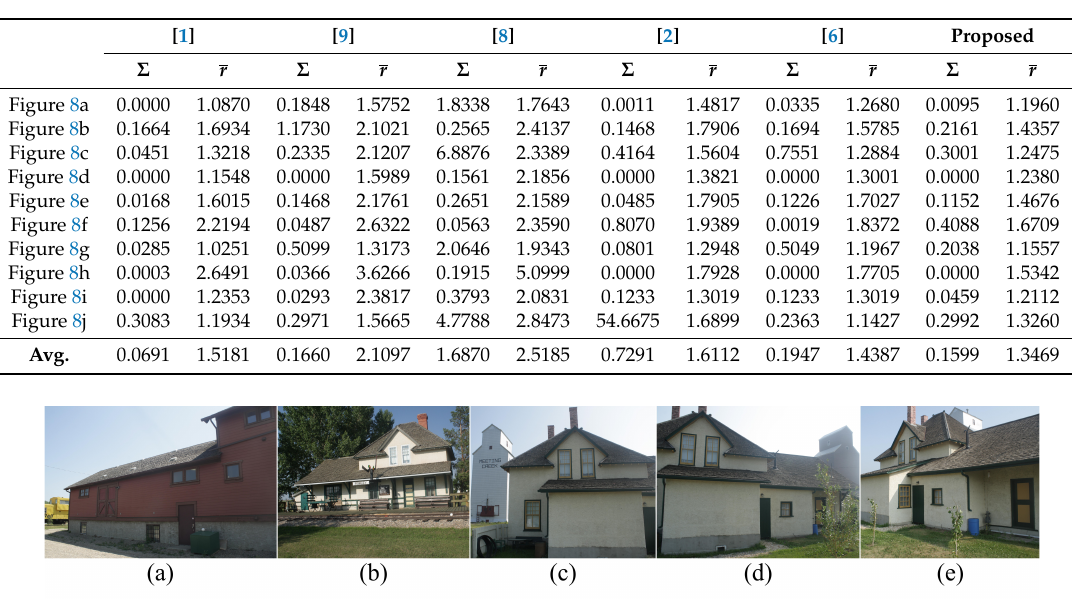
Table 2. Comparison of objective assessments using Hautiere’s method [21].